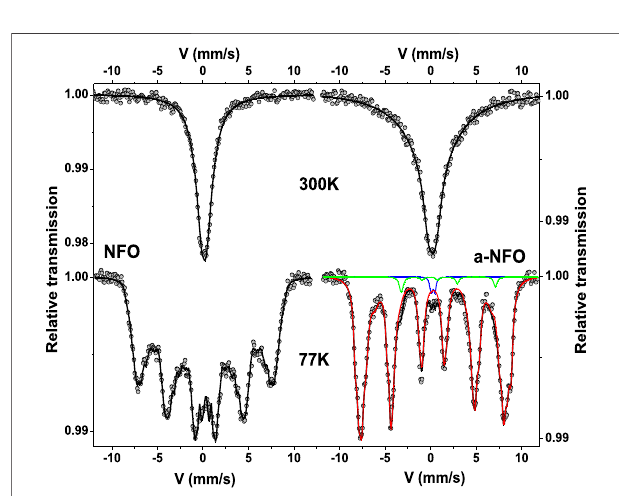
FIGURE 4 | Experimental (back scatters) and theoretical (black line) 300 and77 Kzero- fi eldMössbauerspectraofNFOanda-NFO(more fi ttingdetails supported by green, red, and blue plotted lines are given in the main text for the a-NFO 77 K-spectrum).